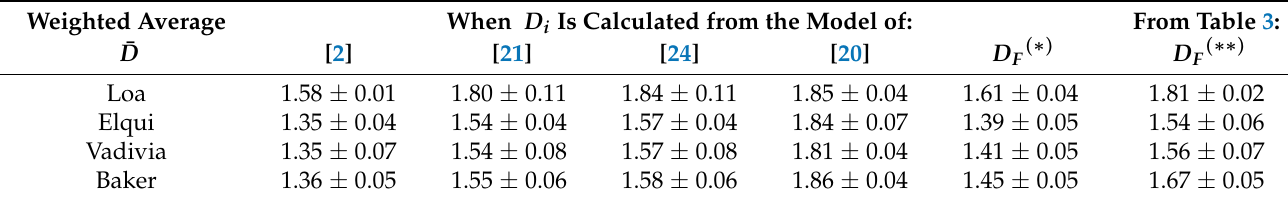
Table 4. Averaged fractal dimension ¯ D obtained from Equation (8) for Loa, Elqui, Valdivia and Baker, calculated according to models D 1 , . . . , D 4 . Fractalyse values ( D F ) were also included for comparison: ( ∗ ) the averaged value of sub-basins and ( ∗∗ ) the dimension of the respective large basin extracted from Table